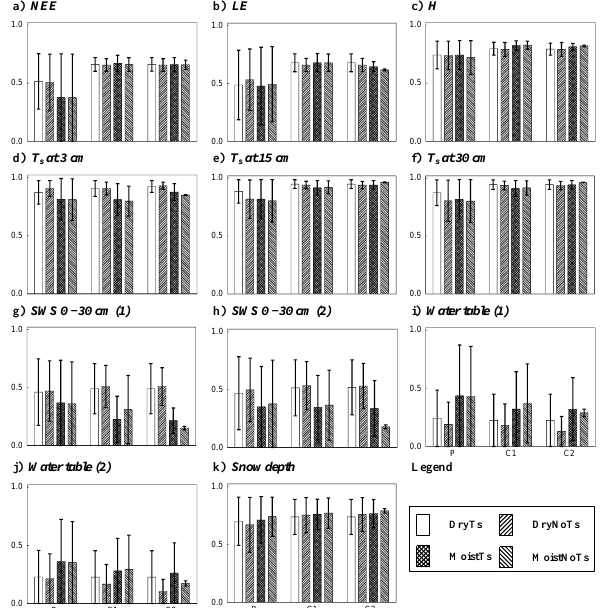
Fig. 4. Statistics of R 2 performance on 11 variables based on DryTs, DryNoTs, MoistTs and MoistNoTs model assumptions when not constrained (posterior (P)) or constrained by C1 or C2, respectively. All bars represent mean values and error bars represent min and max values.